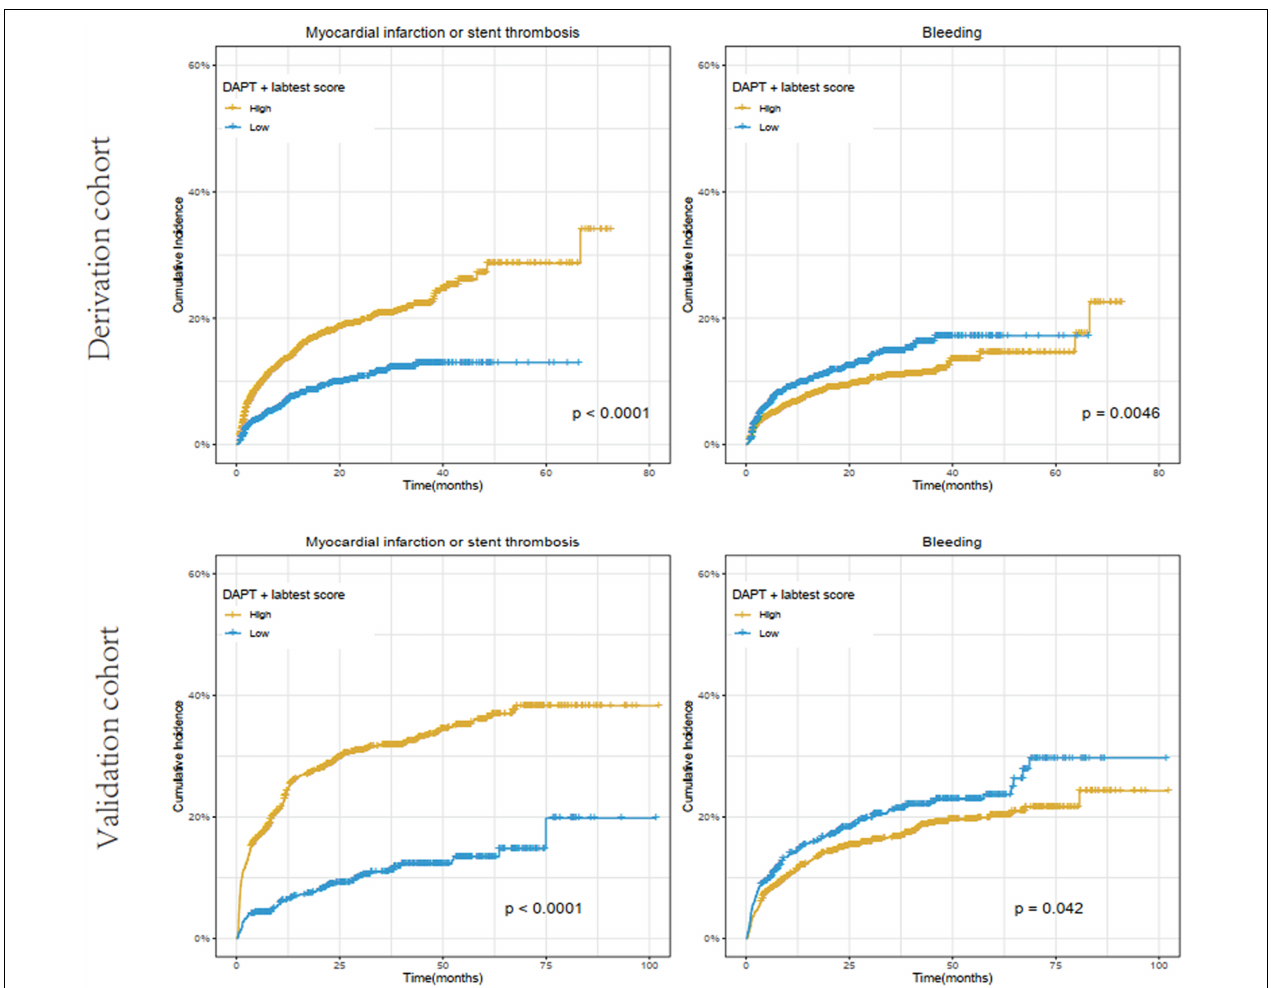
FIGURE 4 | Cumulative incidence of ischemic (myocardial infarction or stent thrombosis) and bleeding events stratified by high ( ≥ 2) vs. low ( < 2) DAPT + labtest (AST + RDW-CV) score in the derivation and validation cohorts. The X-axis represents time (month), while the Y-axis represents cumulative cadences. P < 0.05 was considered to indicate statistically significant